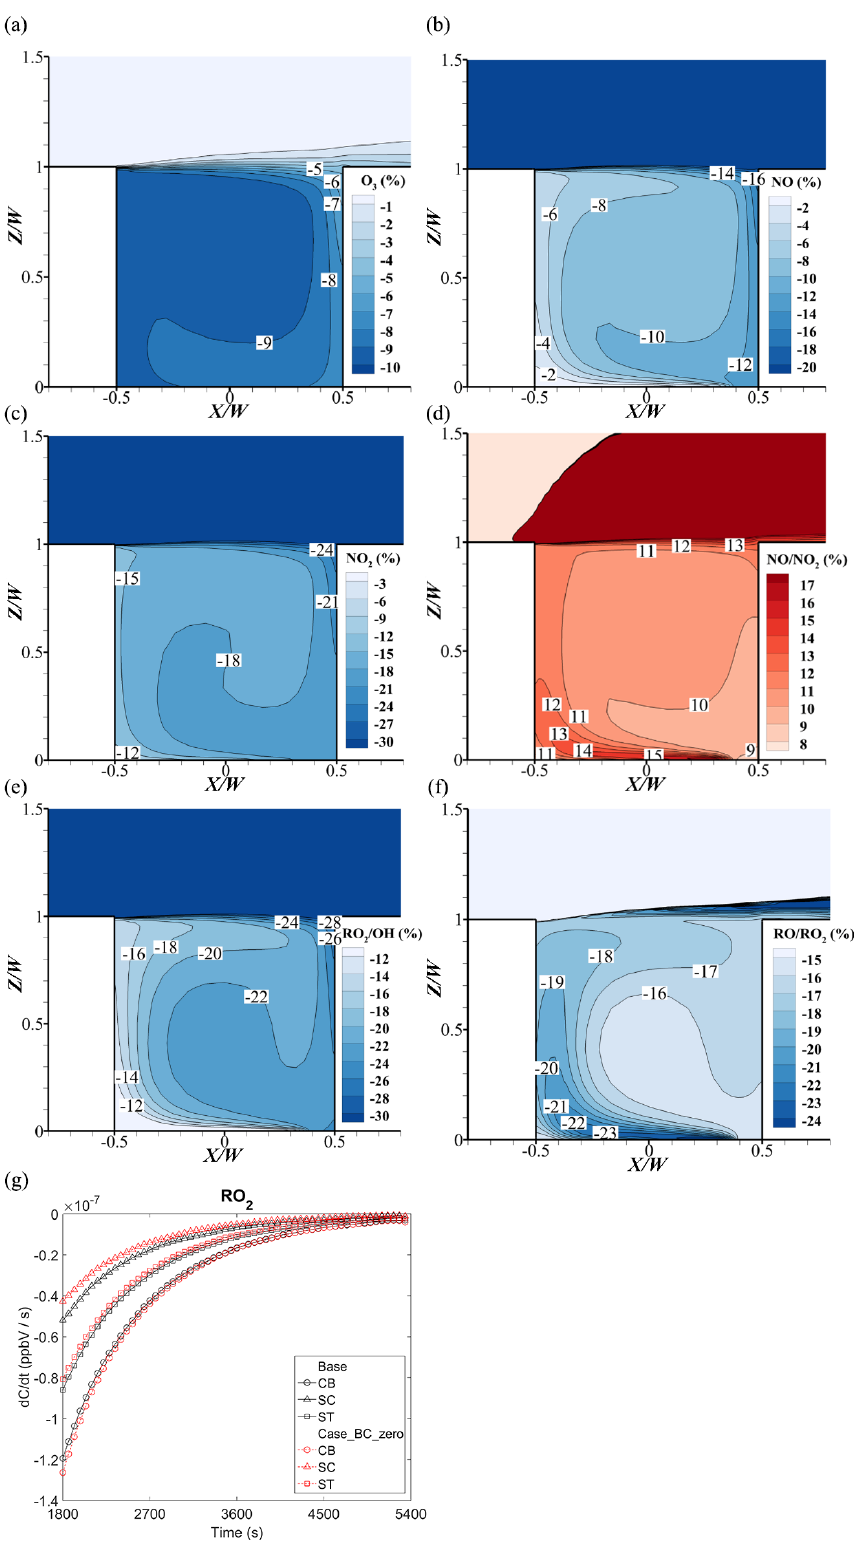
Figure 16. Change rate of (a) O 3 , (b) NO, (c) NO 2 , (d) NO / NO 2 , (e) RO 2 / OH, and (f) RO / RO 2 at t = 5400s . (g) Time series of the reaction rate of RO 2 ( dRO 2 ) of d t